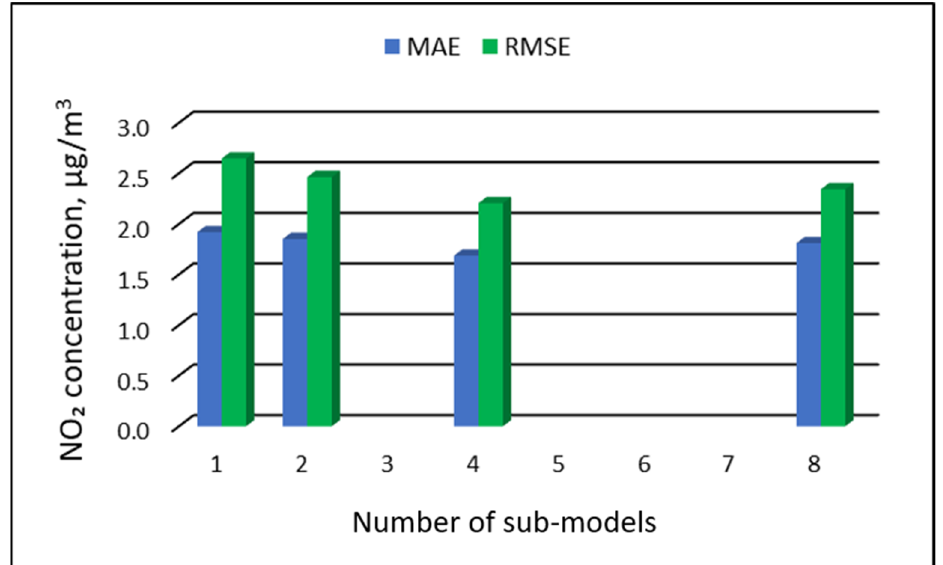
Figure 14. Overall MAE and RMSE values for NO 2 concentration prediction in PVS models depend- ing on the number of created sub-models, Z ł oty Potok.